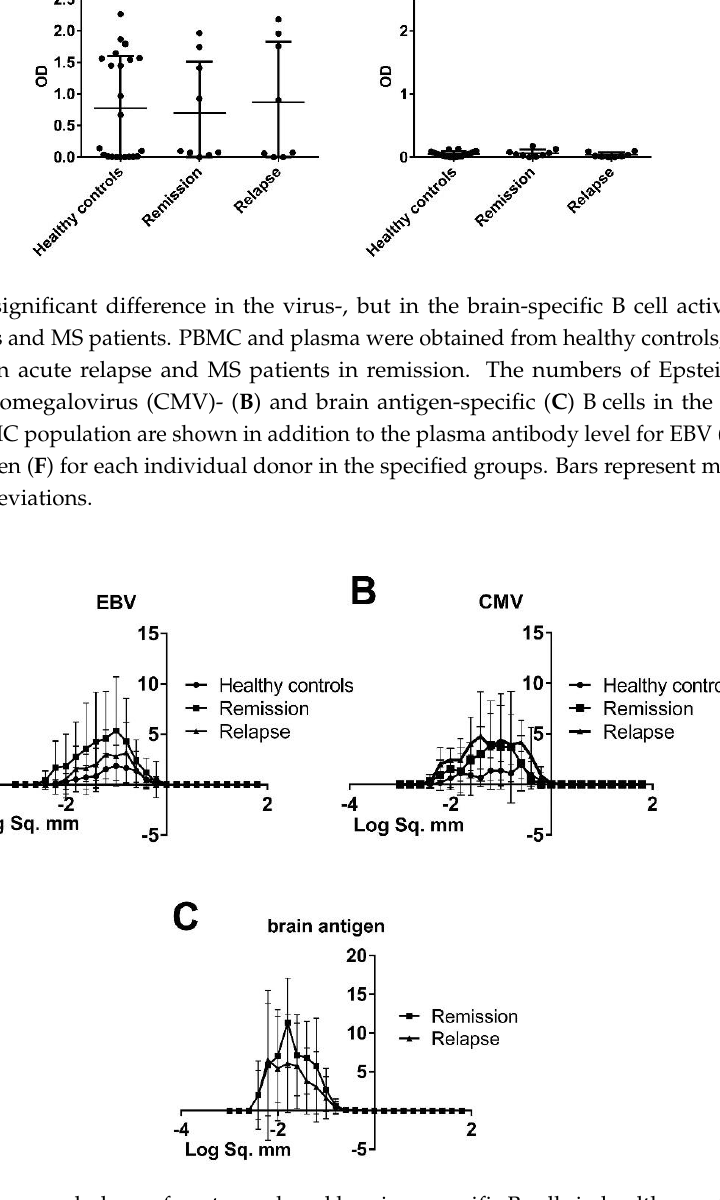
Figure 3. Similar morphology of spots produced by virus-specific B cells in healthy controls and MS patients. The line plots represent the mean spot sizes and standard deviations for EBV ( A ); CMV ( B ) and brain antigen ( C ) detected in the ELISPOT in healthy controls and MS patients experiencing a relapse and in remission. Spot sizes for brain antigen are displayed for MS patients only since spots were absent in healthy controls.